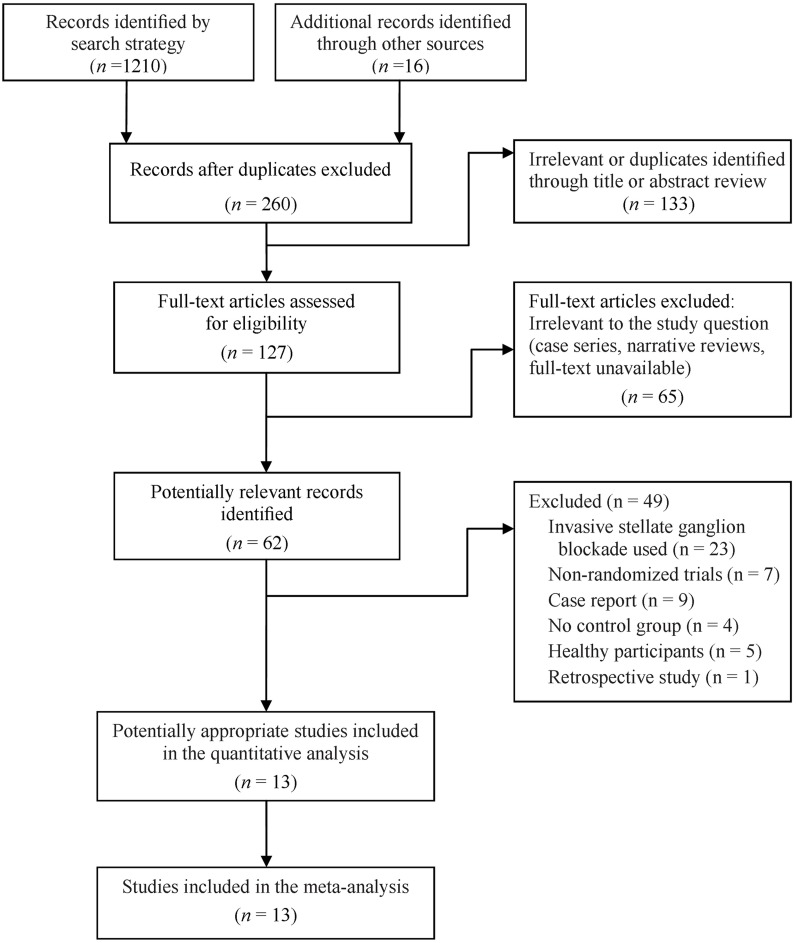
Flow chart of study selection.